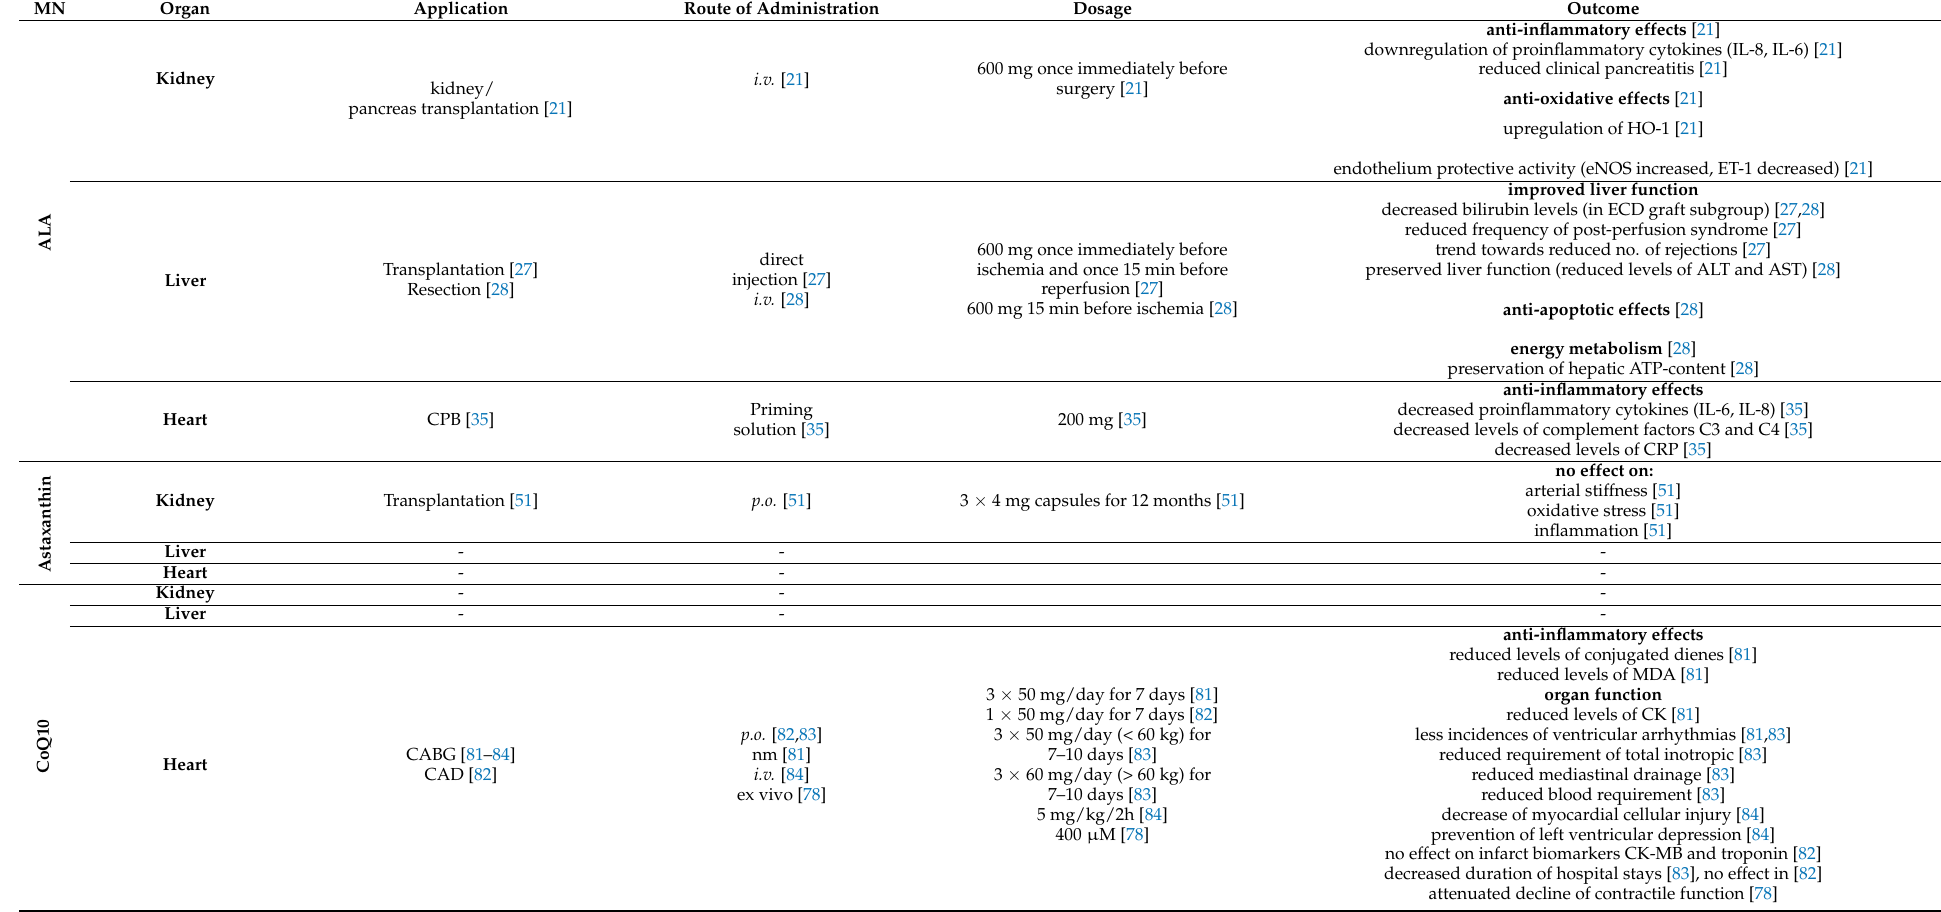
Table 1. Summary of the main clinical findings of the respective micronutrients with reference to the individual organs. Main categories of outcomes are presented in